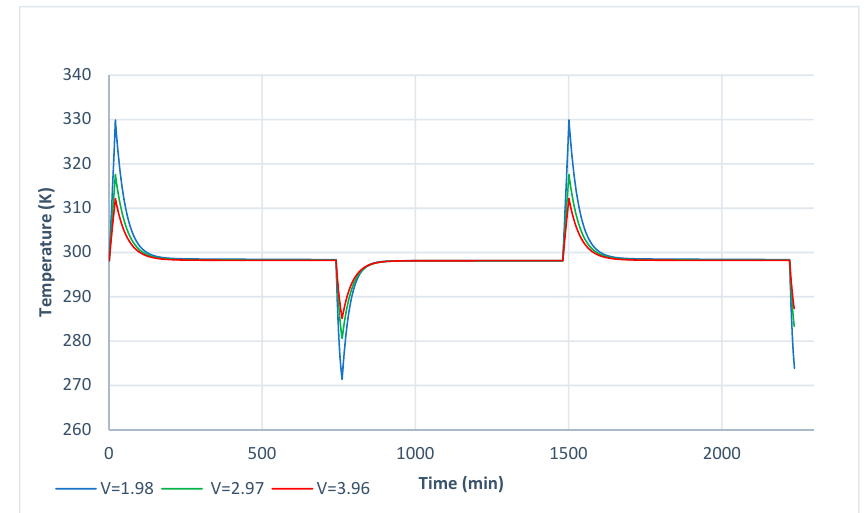
Figure 8. Gas temperature trend for the First Configuration varying the Volume of the tank. Energies 2018 , 11 , 3405